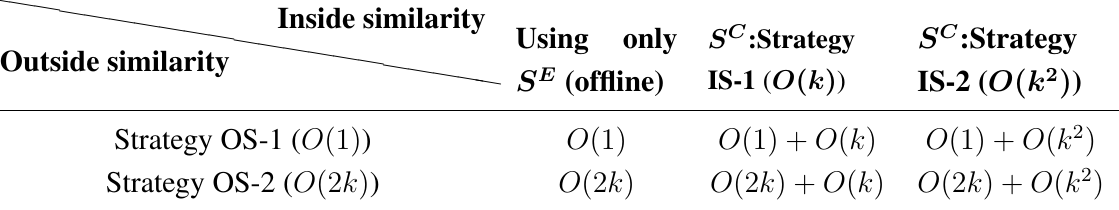
Table 4. Different combinations of strategies to calculate the final match score and their time complexities. S E is calculated by Strategy IS-2, and the computation is